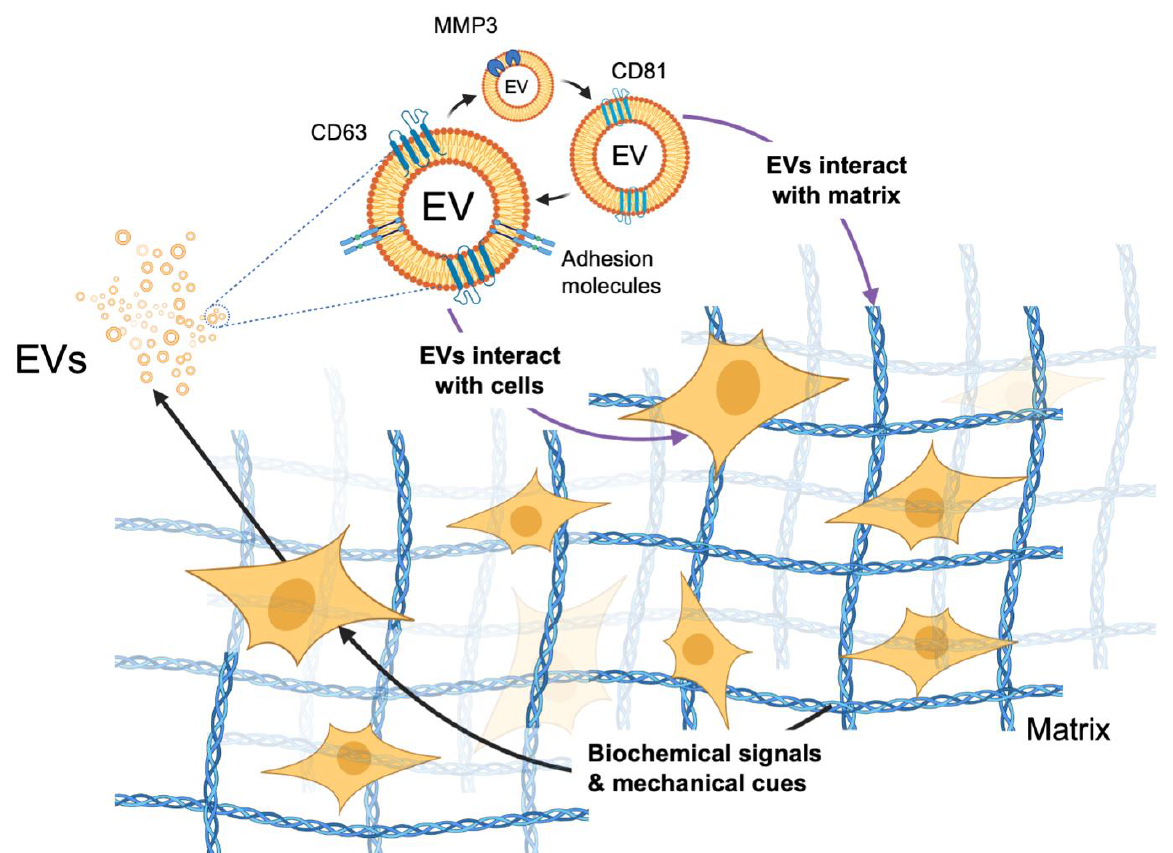
Figure 2. Schematic illustration of tumor microenvironment (TME) showing how the extracellular vesicles (EVs) are secreted by tumor cells that act on other cells in the tumor and on the extracellular matrix (ECM). In the TME, interaction with the ECM also influences tumor cells and lead to EV release. ECM sends biochemical signals and mechanical cues to tumor cells that affects EV biogenesis and cargo loading. Created with BioRender.com (accessed on 3 April 2021).